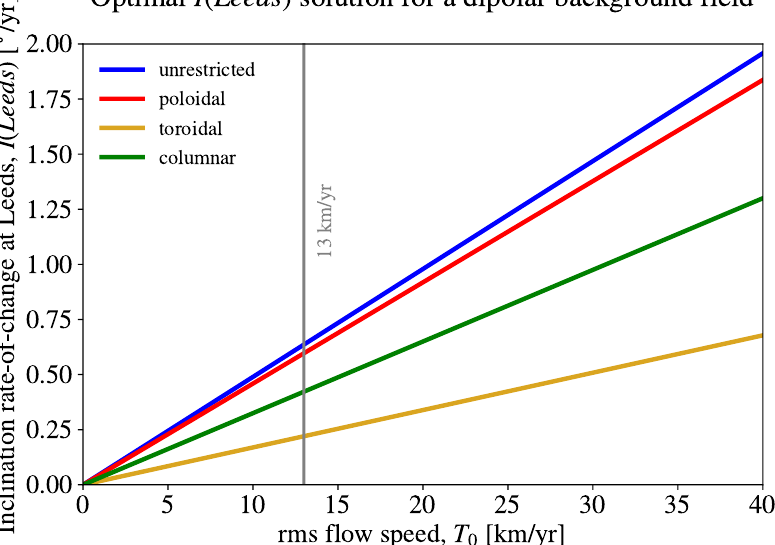
Figure 3. Rate of change of inclination at Leeds, ˙ I ( Leeds ) , for optimal flow calculations with different geometries. The coloured, thick lines were obtained from optimal flow calculations with background = − 29,410.65 nT, for flows with the indicated geometry fields given by an axial dipole described by g 0 1 and for L U = 25. The thin, vertical grey line marks the value T 0 = 13 km/y.